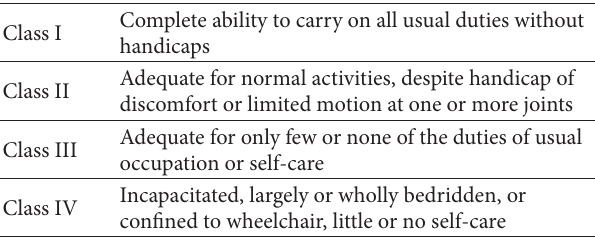
Table 2: American Rheumatologic Association Classification of Global Functional Status